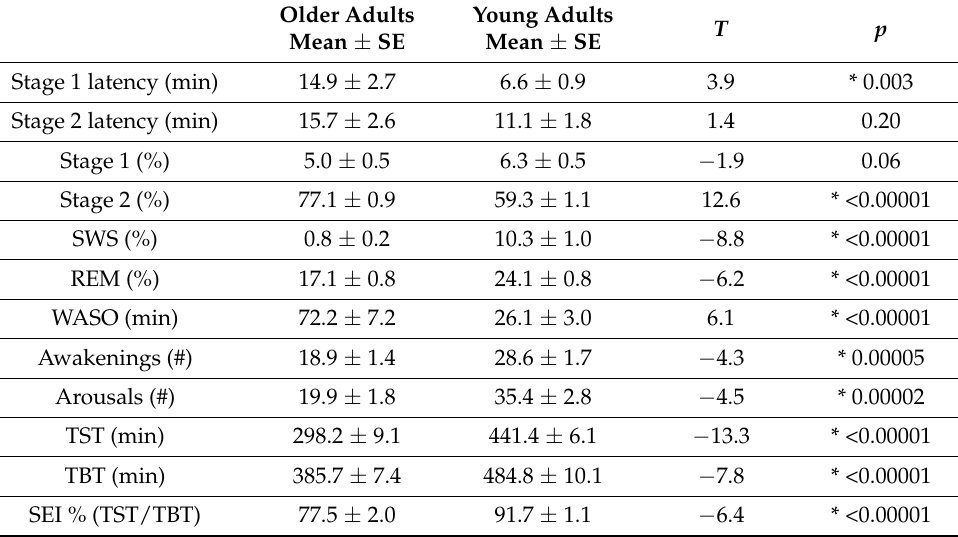
Table 1. Polysomnographic measures. Means and standard errors (SE) of the PSG variables in 36 healthy elderly subjects and 40 healthy young adults. SWS = slow wave sleep; REM = rapid eye movement; WASO = wake after sleep onset; TST = total sleep time; TBT = total bed time; SEI = Sleep Efficiency Index. Results of the comparisons ( t -tests) between the two age groups are also reported. Asterisks index significant